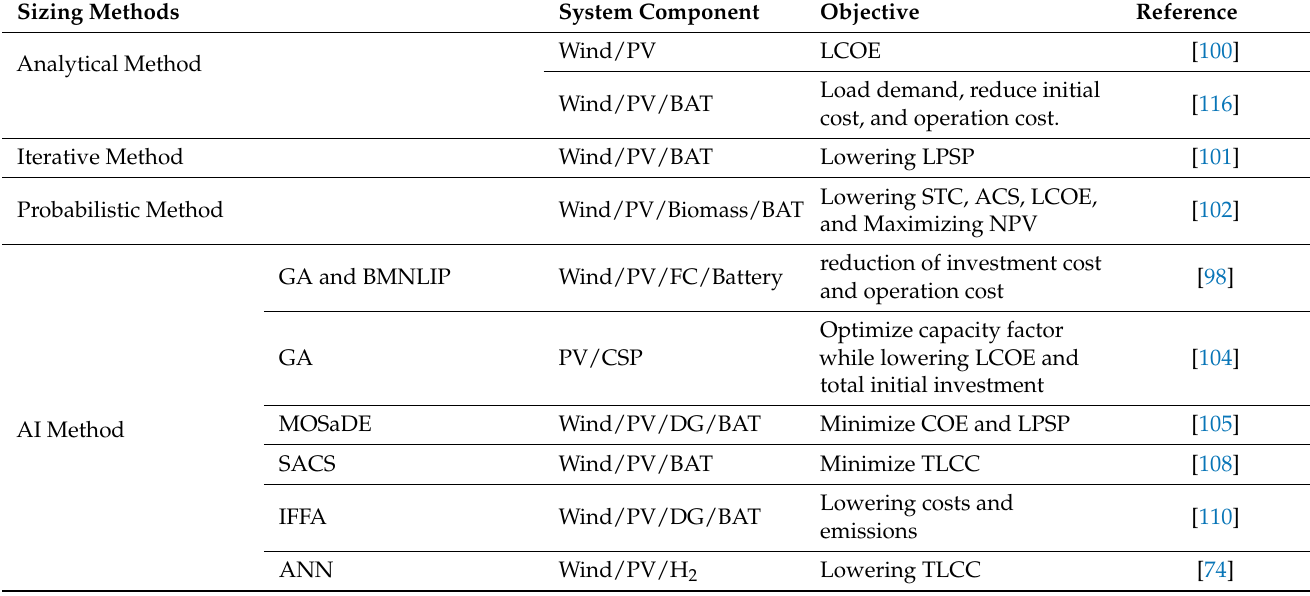
Table 8. Recent studies on optimum